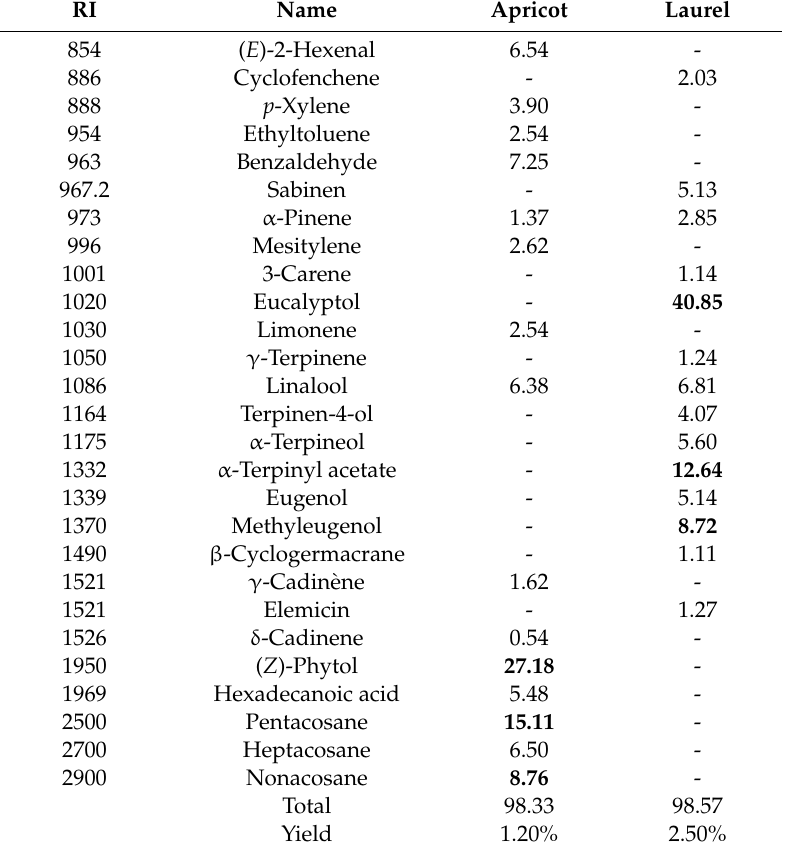
Table 1. Volatile components of essential oils from apricot ( P. armeniaca ) and laurel ( L. nobilis ) leaves. Entries in bold type are major